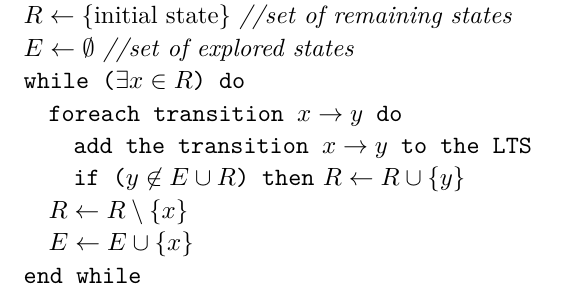
Figure 2 Basic algorithm for LTS